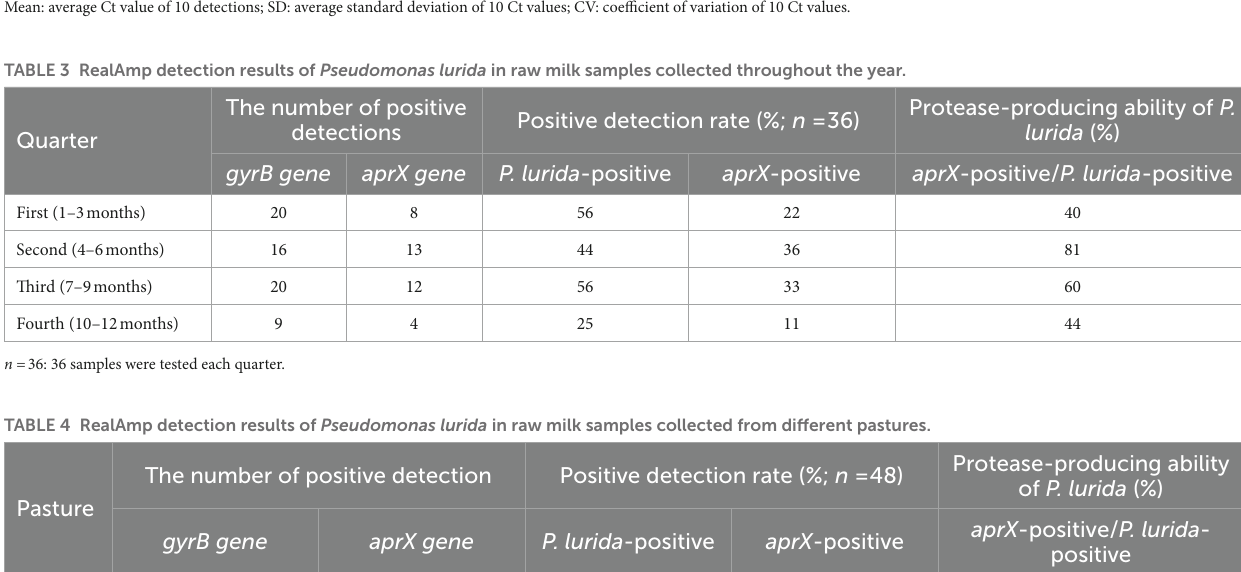
TABLE 3 RealAmp detection results of Pseudomonas lurida in raw milk samples collected throughout the year.